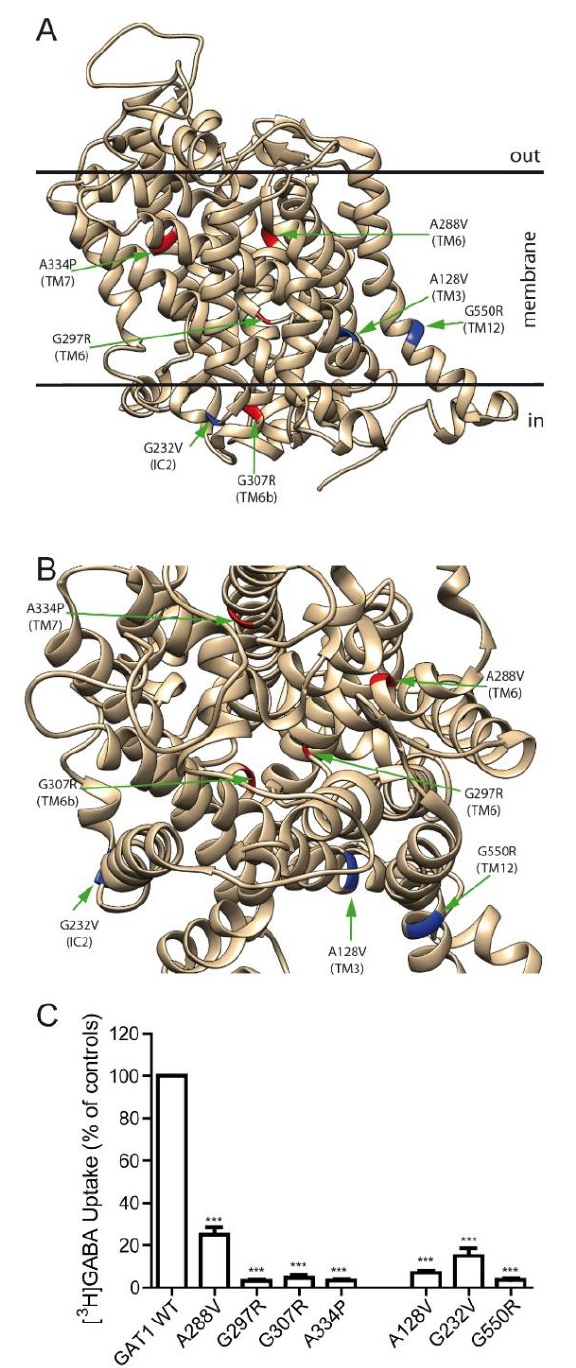
Figure 2. Effect of GAT-1 mutations on its activity. ( A , B ) Lateral ( A ) and top ( B ) view of the ribbon diagram of GAT-1 (PDB: 7sk2) indicating the location of the variants studied in this article. Peripheral mutations are indicated in blue, and those located within the permeation pathway in red. The position of the membrane is indicated in the lateral view by two black lines. ( C ) GABA uptake activity measured in transfected HEK293 cells. Cells were transfected and 48 h later were incubated for 10 min in the presence of 0.1 µ Ci of [ 3 H]GABA, and the incorporated radioactivity was determined in a scintillation counter. Values represent the percentage of the activity observed in the wild-type control (GAT-1 WT) after correction for the background observed in mock-transfected cells. Values are the means ± SEM of three experiments. Average CPM values per well were 5387 for the controls and 254 for the mock-transfected cells. Values are the mean ± SEM of four experiments. ***: p < 0.001, paired t -test.